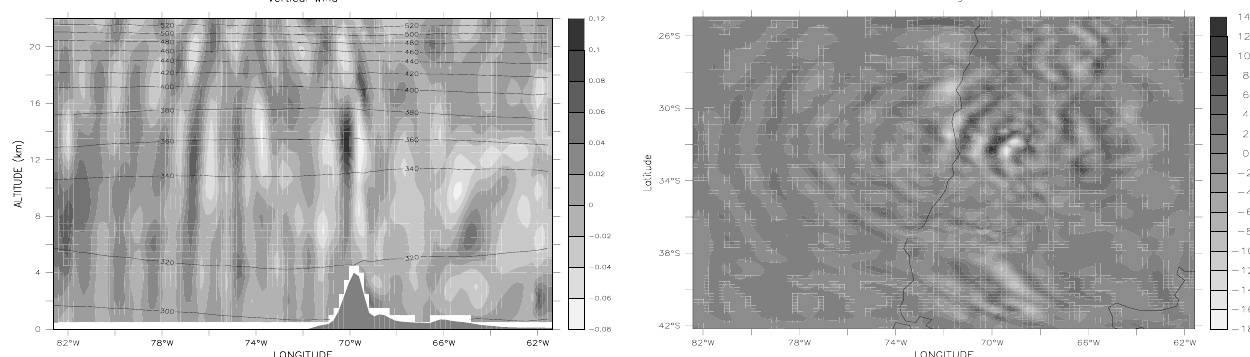
Fig. 7. Case 1: Results of the WRF simulations. Left: Vertical wind velocity (ms − 1) and isentropes (K). Longitude-altitude cross section at the Santo Domingo latitude. Right: Horizontal wind divergence (s − 1). Horizontal section at the altitude 20km. Similar figure is obtained at lower altitudes, e.g. at 13km.